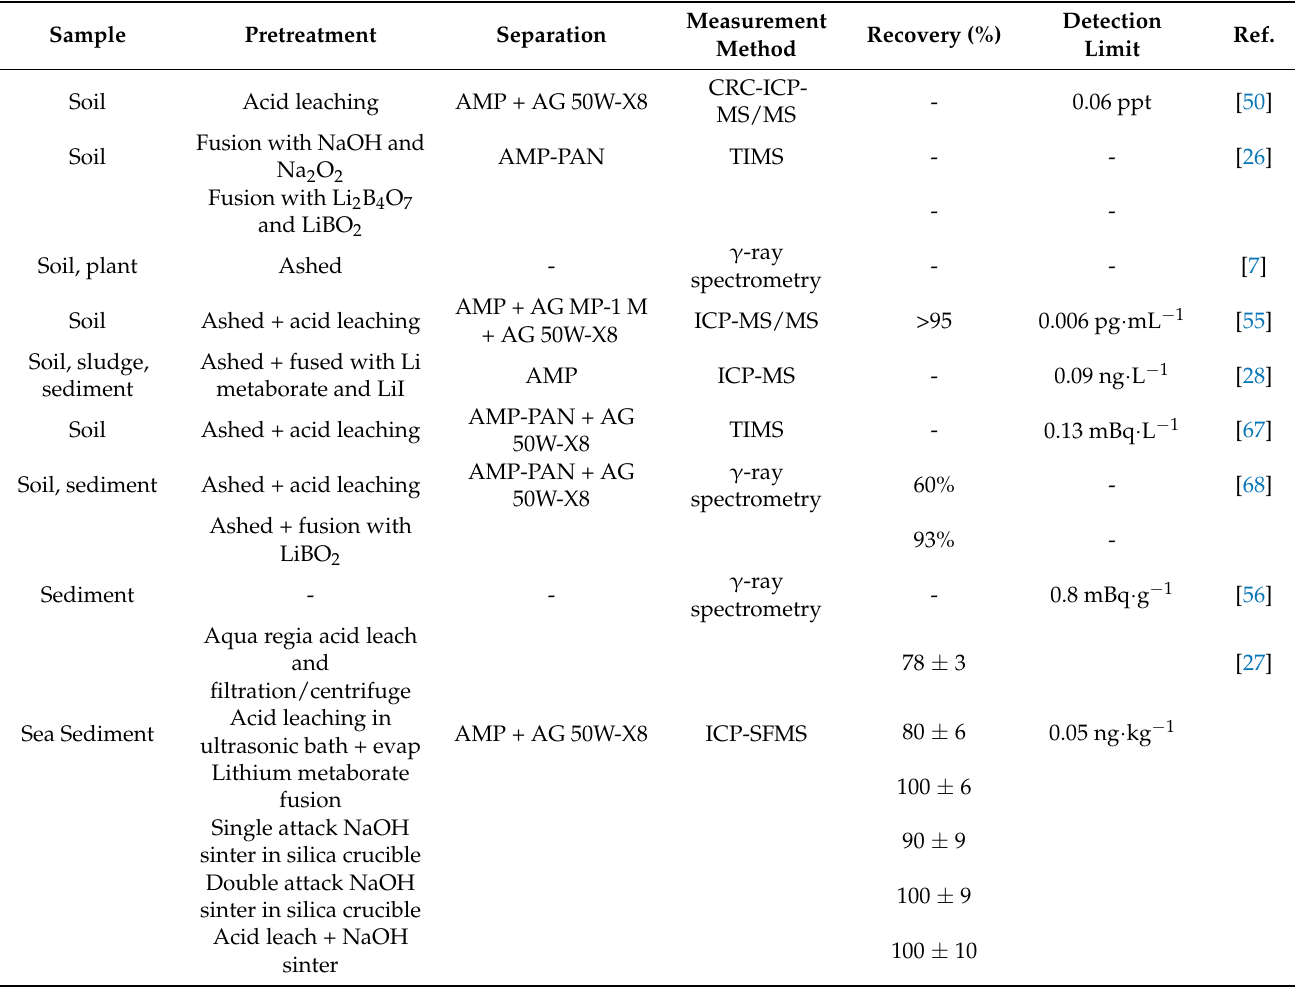
Table 2. Performance parameters of 137